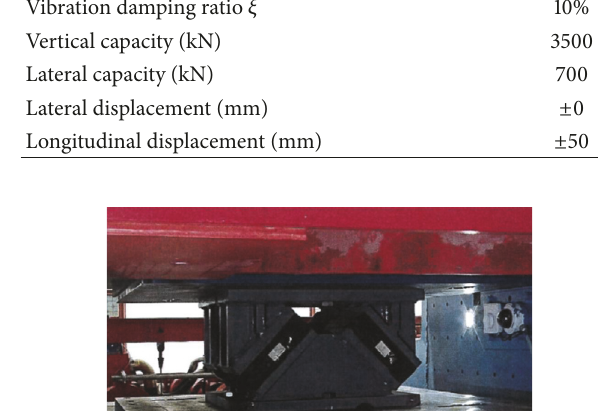
Figure 4: Deformation of the novel bearing under compression load.